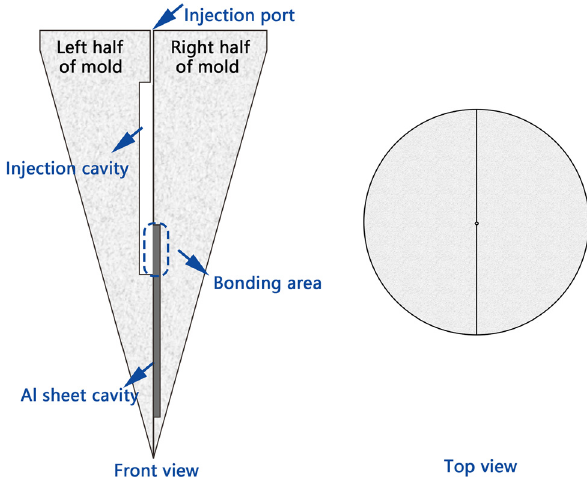
Figure 1: Schematic illustration of injection mold.